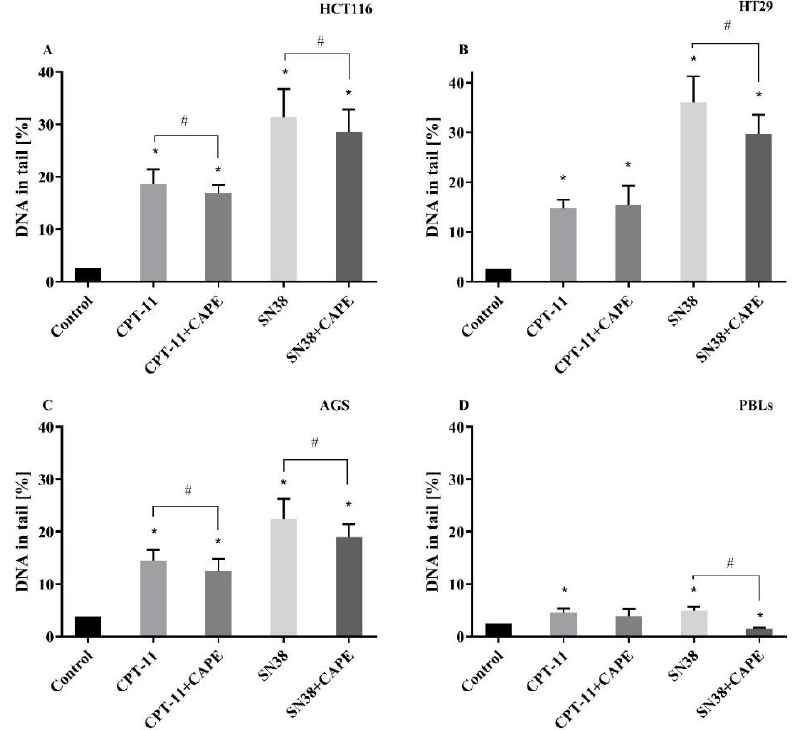
Figure 7. DNA damage measured in HCT116 ( A ), HT29 ( B ), AGS ( C ) and PBLs ( D ) as the percentage of DNA in the comet tail in the alkaline version of comet assay incubated 24 h with CAPE in the presence of CPT-11 or SN38 (mean ± S.E.M). * p < 0.05 as compared with control (untreated) cells; # p < 0.05 as compared with cells treated